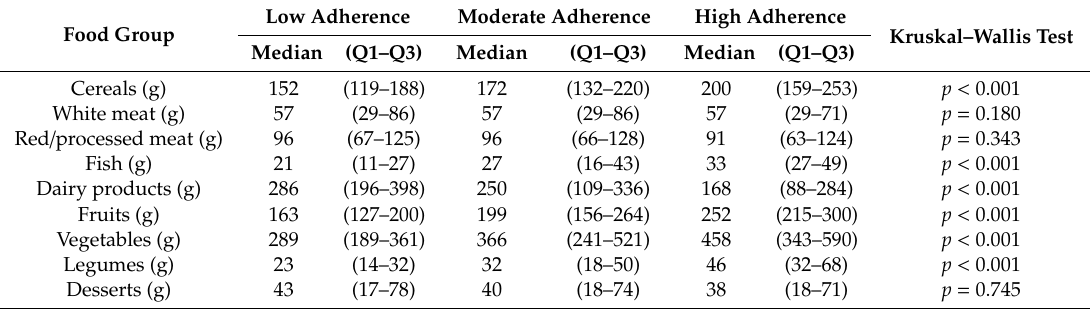
Table 2. Median intake of food groups and interquartile range (Q1–Q3) according to adherence to Mediterranean diet.